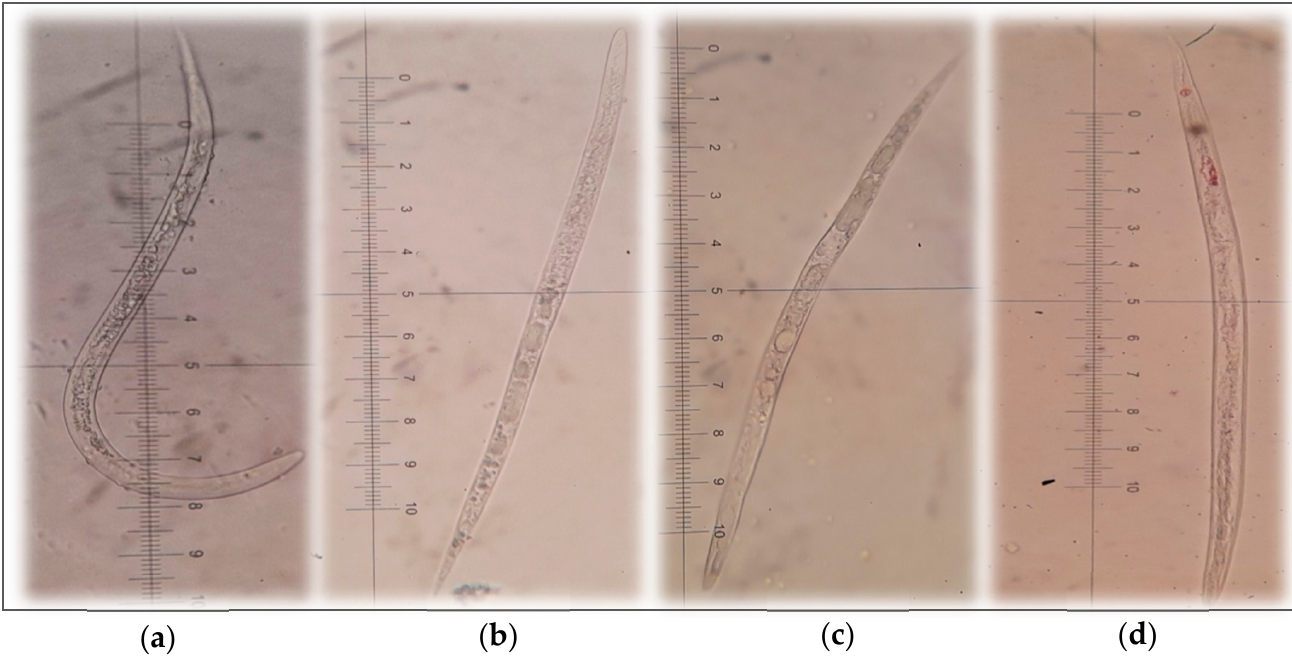
Figure 9. The images of mobilized J2 nematodes in control samples ( a ) immobilized J2 nematodes after being treated by hemi-pyocyanin ( b ), the crude pigments ( c ), and prodigiosin ( d ). The images of J2 were taken under stereoscopic microscope Olympus SZ5.